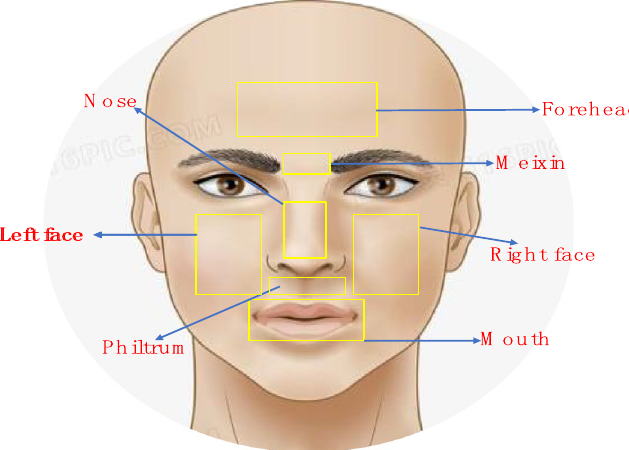
Figure 3. Example position for the selected ROI (Note: Meixin is the eyebrow center (middle eyebrow region)). The ROI of the face is defined as different objects as possible ROI, such as forehead, nose, left face, right face, mouth, meixin and